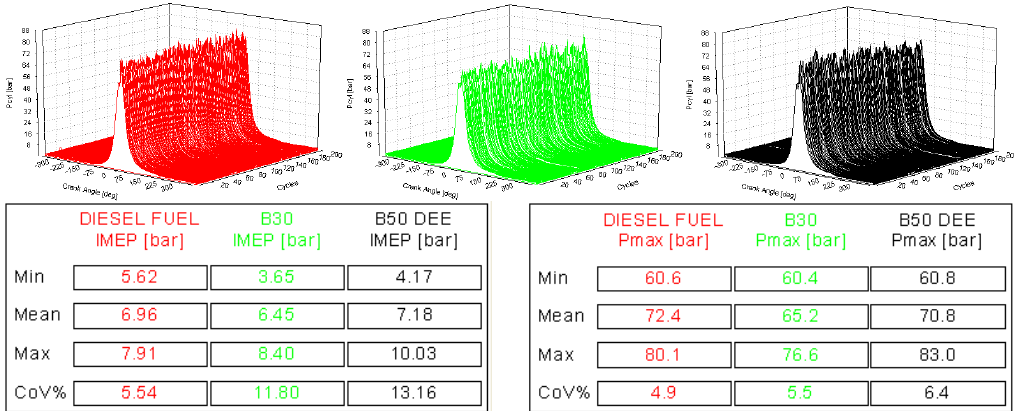
Figure 11. Cycle ‐ to ‐ cycle analysis during the idling stage. Figure 11. Cycle-to-cycle analysis during the idling